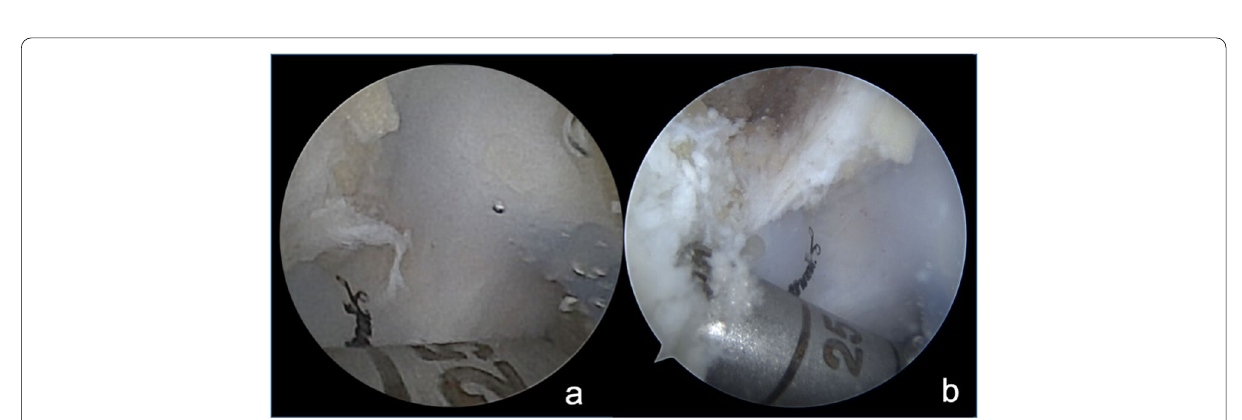
Fig. 6 Talar tunnel drilling. A NanoScopeTM view. B Standard arthroscope